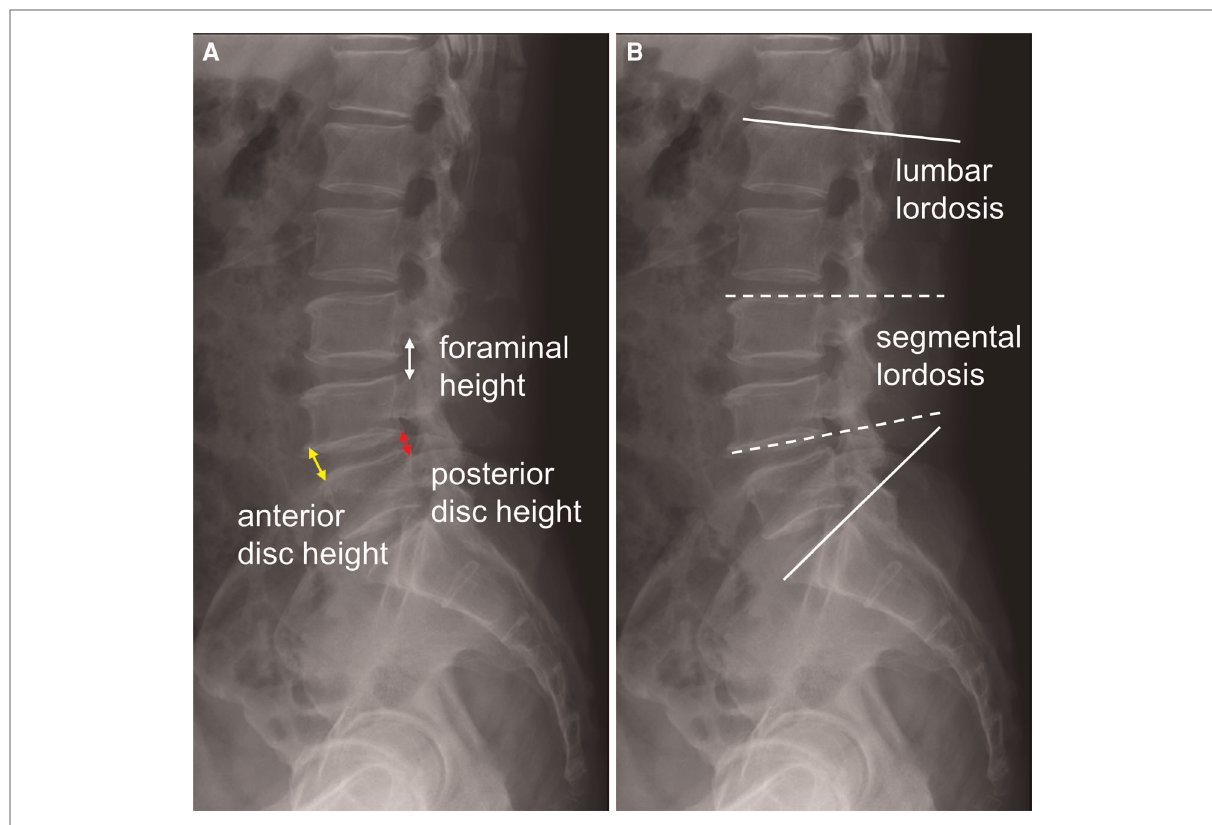
FIGURE 2 The radiologic parameters ( A ) anterior disc height (ADH, yellow arrow): the distance of the anterior disc space; posterior disc height (PDH, red arrow): the distance of the posterior disc space; average disc height (DH): (ADH+PDH)/2; foraminal height (FH, white arrow): the distance between the pedicles of upper and lower levels; ( B ) lumbar lordosis (LL, solid line): the angle of L1 to S1 upper endplate; segmental lordosis (SL, dotted line): the angle of the upper endplate of the upper vertebra and the lower endplate of the lower vertebra of the index